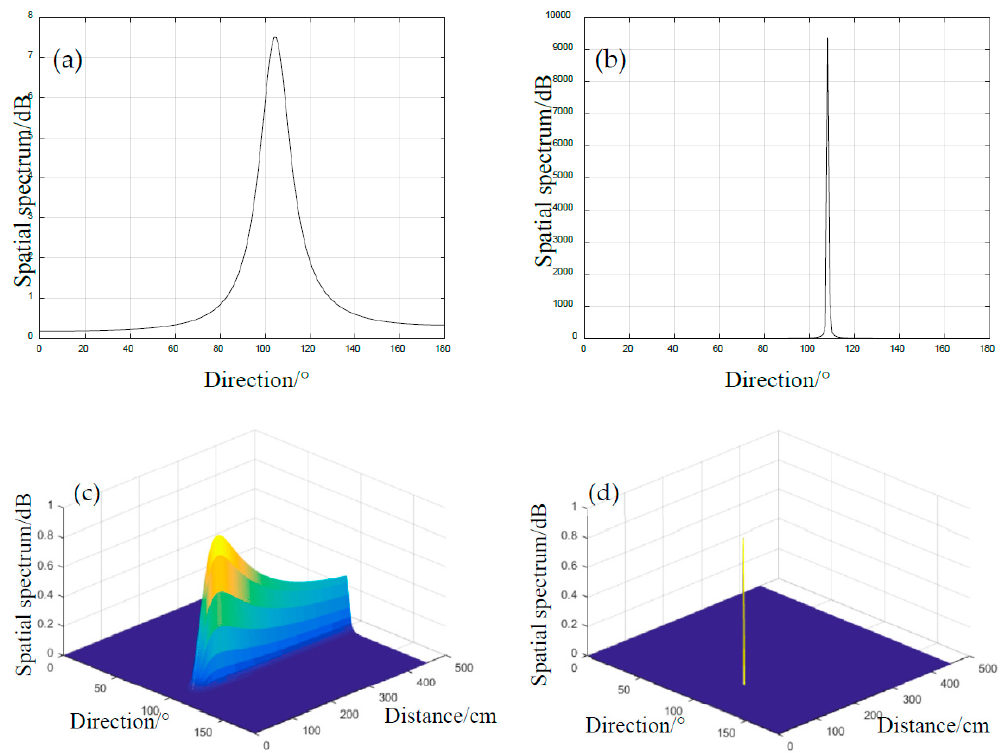
Figure 8. Spatial spectrum of case #1 estimated by ( a ) classical 1D-MUSIC algorithm, ( b ) error calibration based 1D-MUSIC algorithm, ( c ) standard 2D-MUSIC method and ( d ) the proposed method.